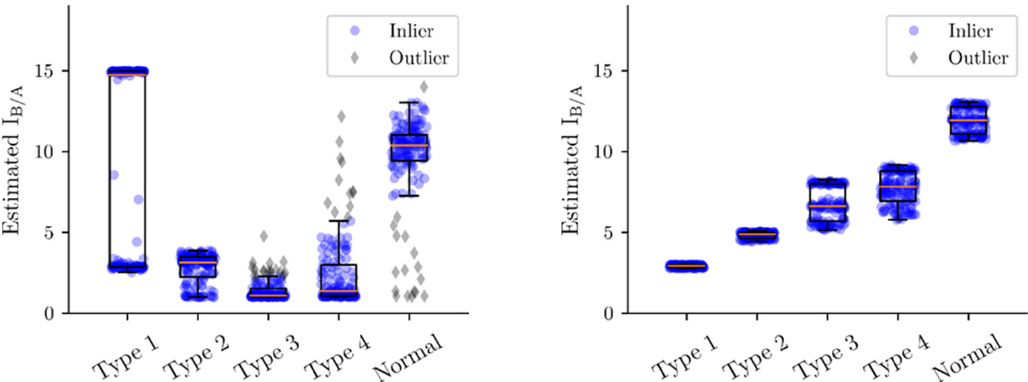
Figure 4. Scatter plots of I B/A for y(t) (left plot ) and z(t) ( right plot ), corresponding to the left upper plots of Figures 2 and 3, respectively. In the case of z(t), the trend of estimates was consistent with the setting, i.e., graded increase of I B/A from Type 1 EEGs to normal EEGs. In addition, three bands, corresponding to three values of A (Figure A1), can be seen. The boxplot for each group has a standard form, displaying the inter-quartile range (box), the range of inliers (error bar), and the median (orange line).